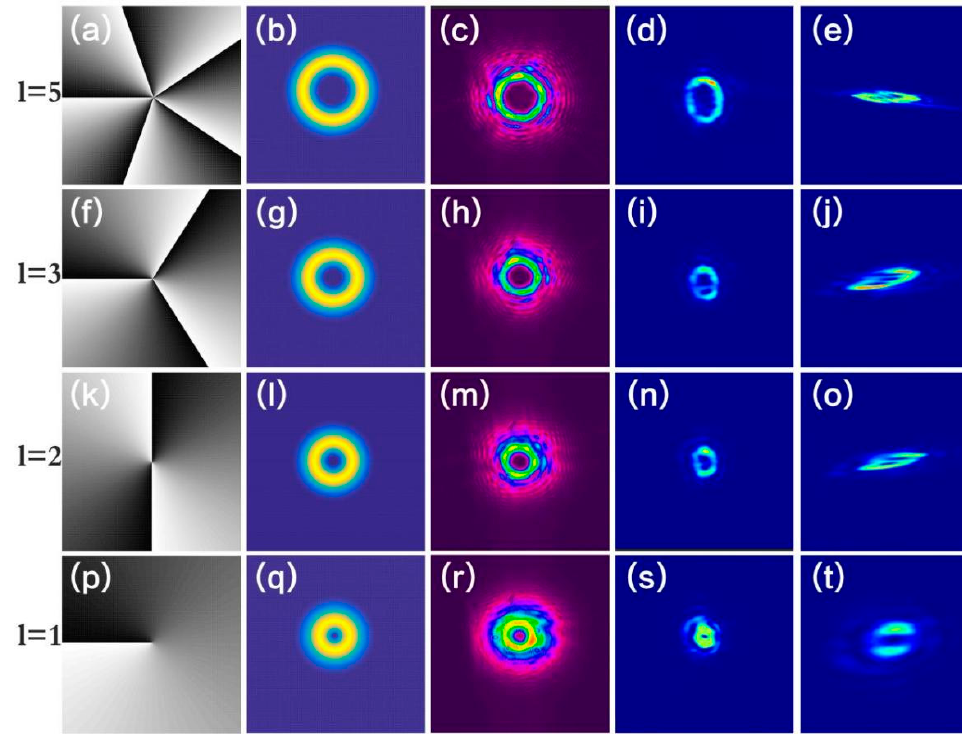
Figure 3. Light intensity distribution and phase distribution during propagation of the vortex optical field. ( a , f , k , p ) Spiral phase diagrams of different topological charges loaded by spatial light modulators. ( b , g , l , q ) are the theories that accurately model the lateral light field distributions carrying light fields of l = 5, 3, 2, 1. ( c , h , m , r , d , i , n , s ) represent the input and output light fields with topological charge L = 5, 3, 2, 1 ( c , h , m , r ) show the distribution of the input light fields. In addition, ( d , i , n , s ) represent the distribution of the output light fields). The lateral light field distribution maps of ( e , j , o , t ) are the lateral light field structures of the output light field after being compressed by a cylindrical lens carrying a 1300 nm laser with l = 5, 3, 2, 1. ( a , f , k , p , b , g , l , q ) are numerical simulation graphs, and ( c , h , m , r , d , i , n , s , e , j , o , t ) are experimental results.